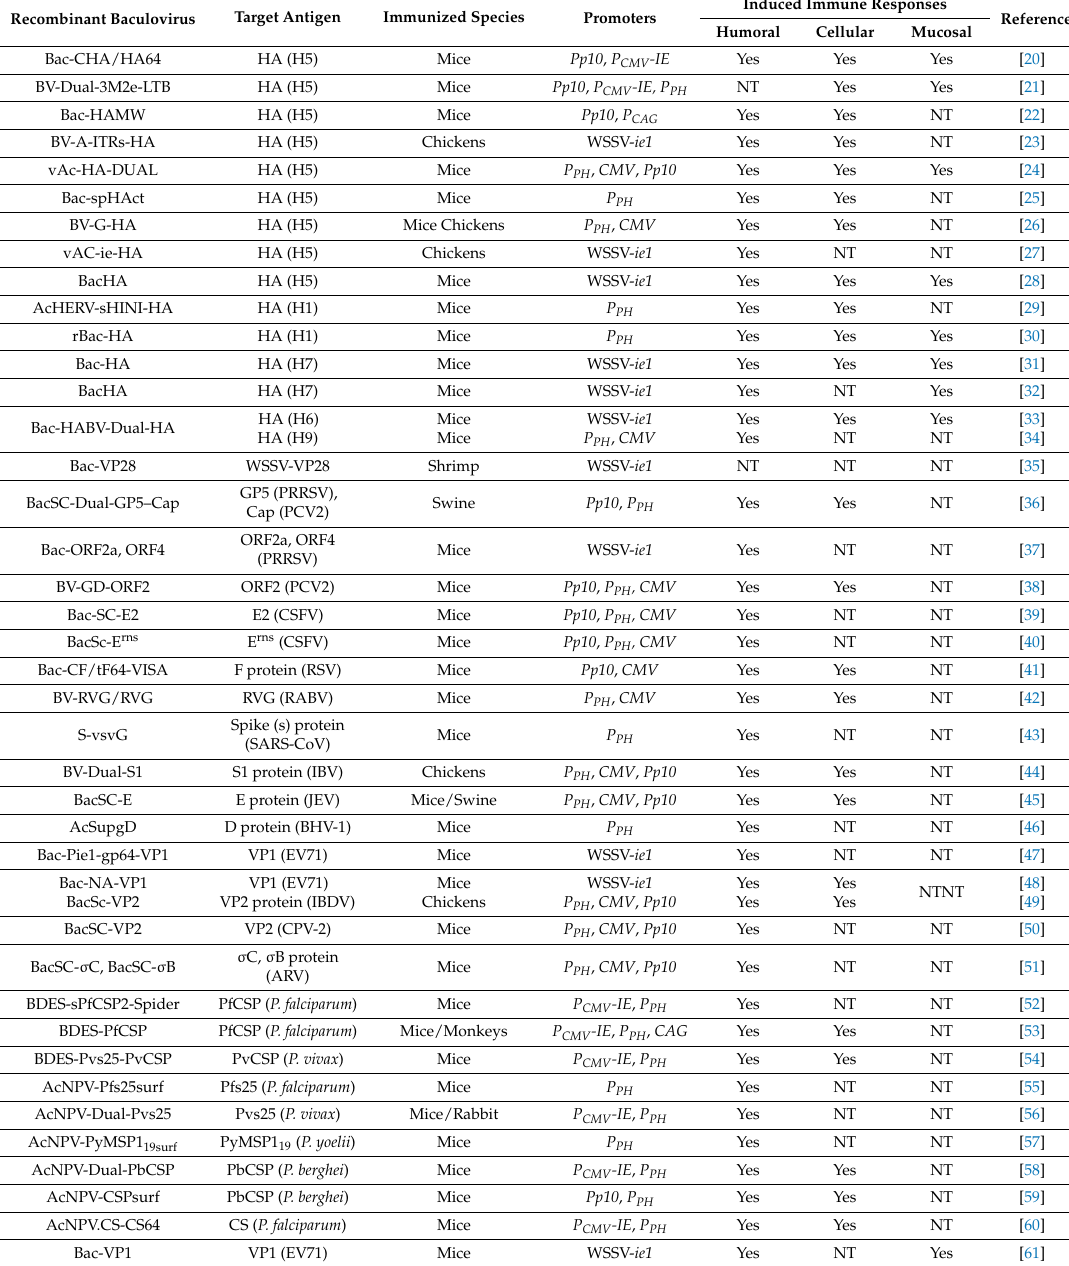
Table 1. Recombinant baculovirus displayed antigens against infectious